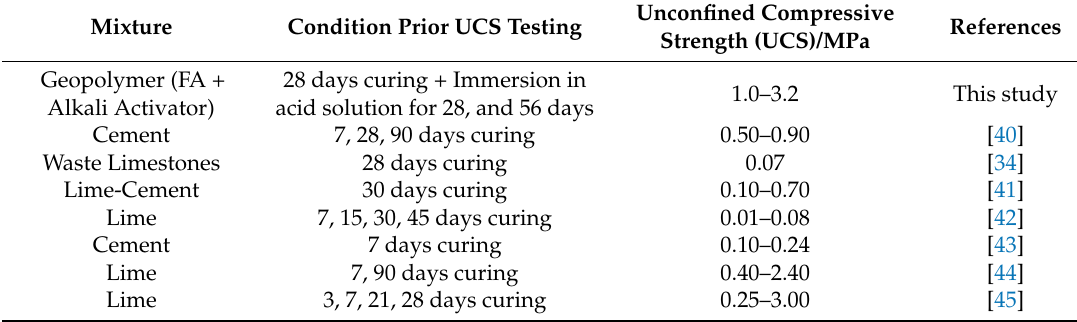
Table 3. Unconfined compressive strength between lime/cement stabilized soil and soil-fly ash geopolymer cement.